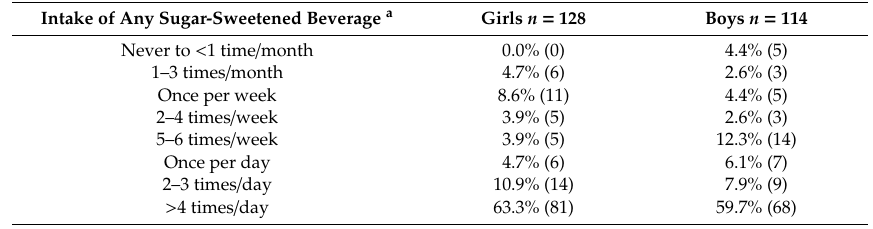
Table 1. Percent (% [N]) of participants reporting intake of any sugar-sweetened beverages among 242 Early Life Exposure in Mexico to Environmental Toxicants (ELEMENT) project